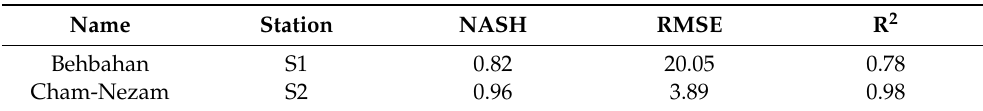
Table 8. Indicators for the NASH parameter, root mean square error (RMSE) and the coefficient of determination (R 2 ) for observational and simulated data. Table 7. Test statistics in the validation stage.